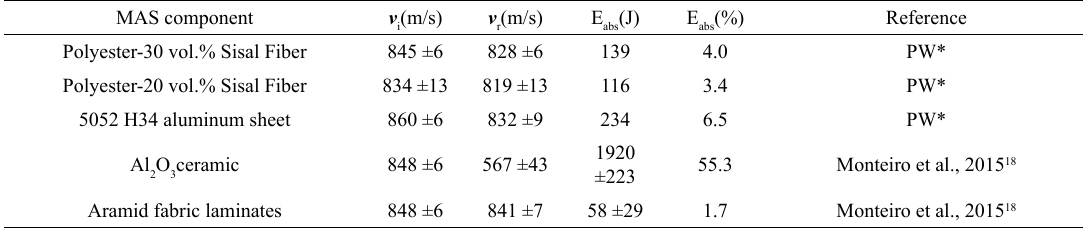
Table 4. Impact and residual velocities with internally dissipated energy in individually ballistic tested MAS components. MAS component